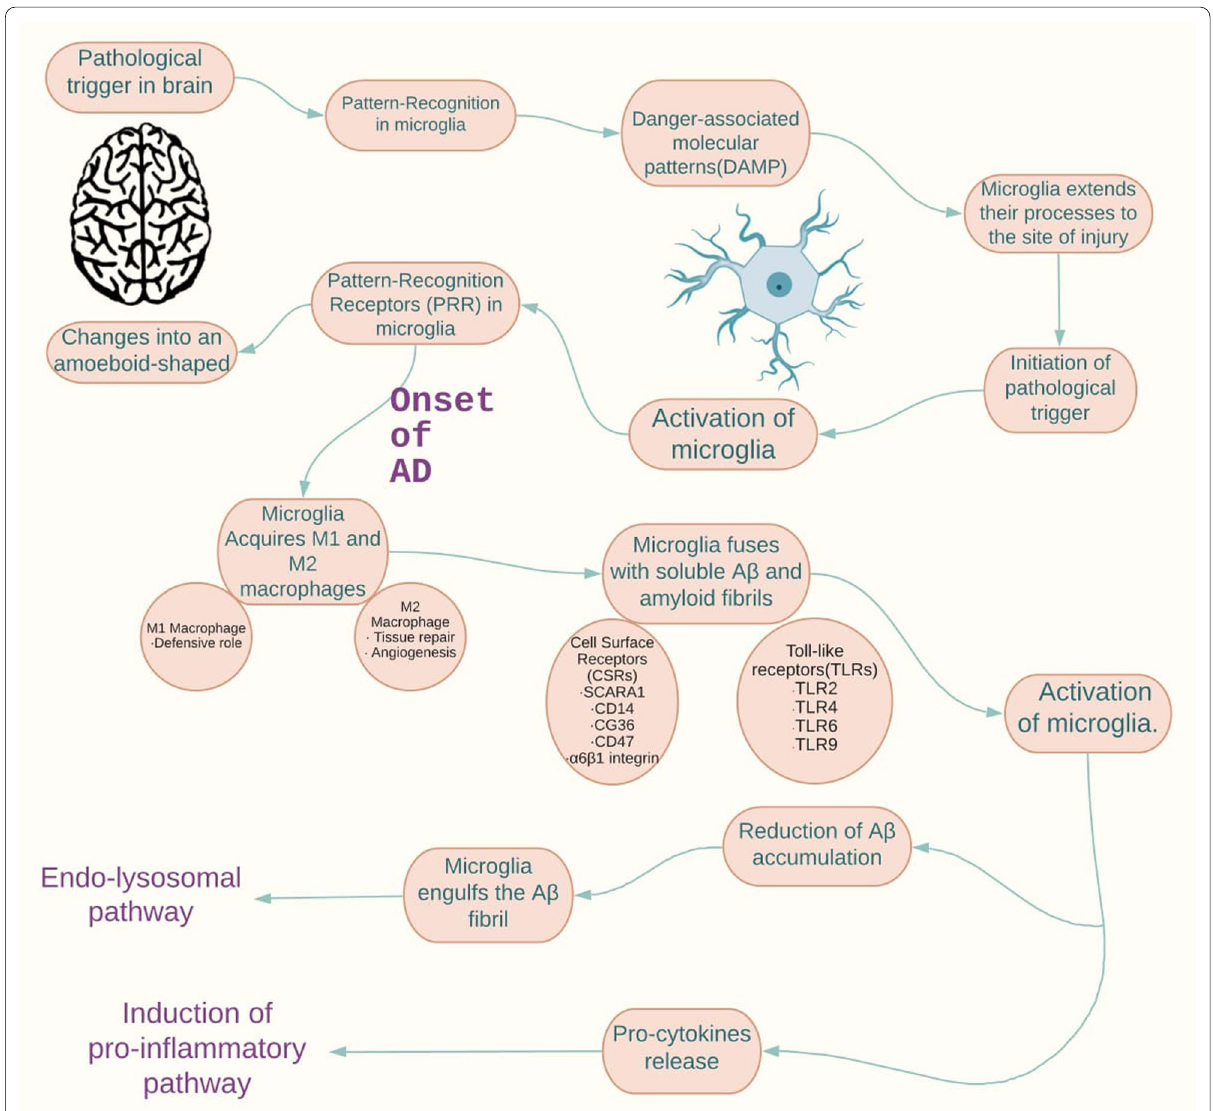
Fig. 3 Pathological interplay between microglia and macrophages in AD. Pathological trigger is detected by Pattern-Recognition Receptors (PRRs) in microglia recognized by pathogen-associated molecular patterns (PAMPs) or danger-associated molecular patterns (DAMPs). The protein cascade induces microglia to initiate immune response at the injury site by acquiring M1 and M2 macrophages. Furthermore, microglia fuse with soluble Aβ through cell surface receptors (CSRs)/ Toll-like receptors (TLRs) and amyloid fibrils resulting in its activation and leading to phagocytosis, clearance and degradation of Aβ. The engulfment of Aβ turn on the endo-lysosomal pathway in microglia. On the other hand, prolonged activation of microglia leads to release of pro-cytokines that induces pro-inflammatory